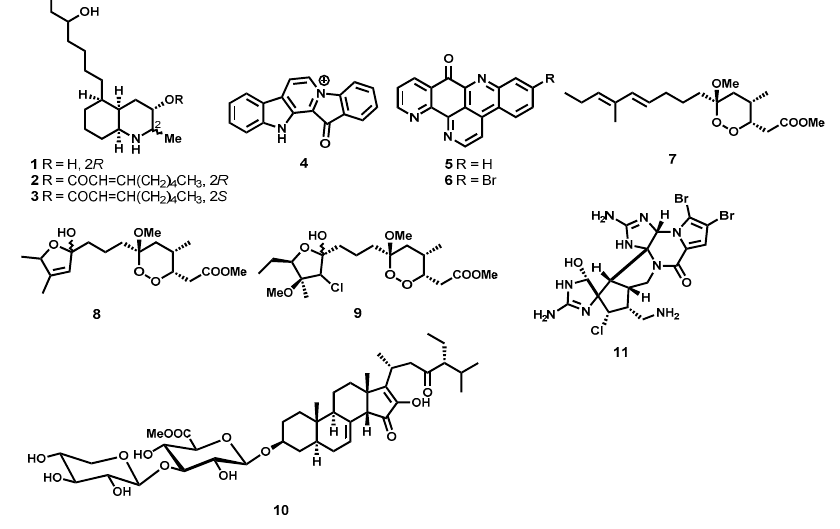
Figure 2. Trypanocidal alkaloids, saponins, and peroxides isolated from marine organisms. Peroxides and Saponins Peroxides and